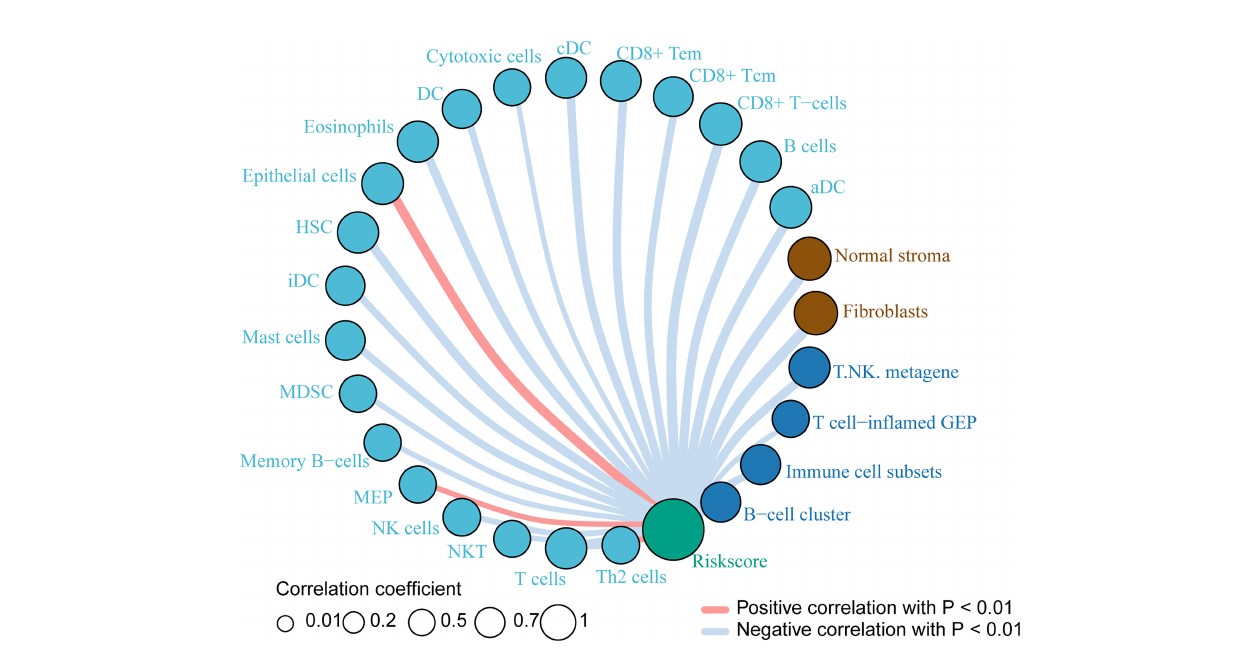
FIGURE 5 | Immune cells related to risk index Immune cells associated with the risk index of PACA-AU patients. The red line indicates a positive correlation between the risk index and immune cells, and the gray line indicates a negative correlation between the risk index and immune cells. The size of the circle indicates different correlation coef fi cients, and the larger the area of the circle, the larger the correlation coef fi